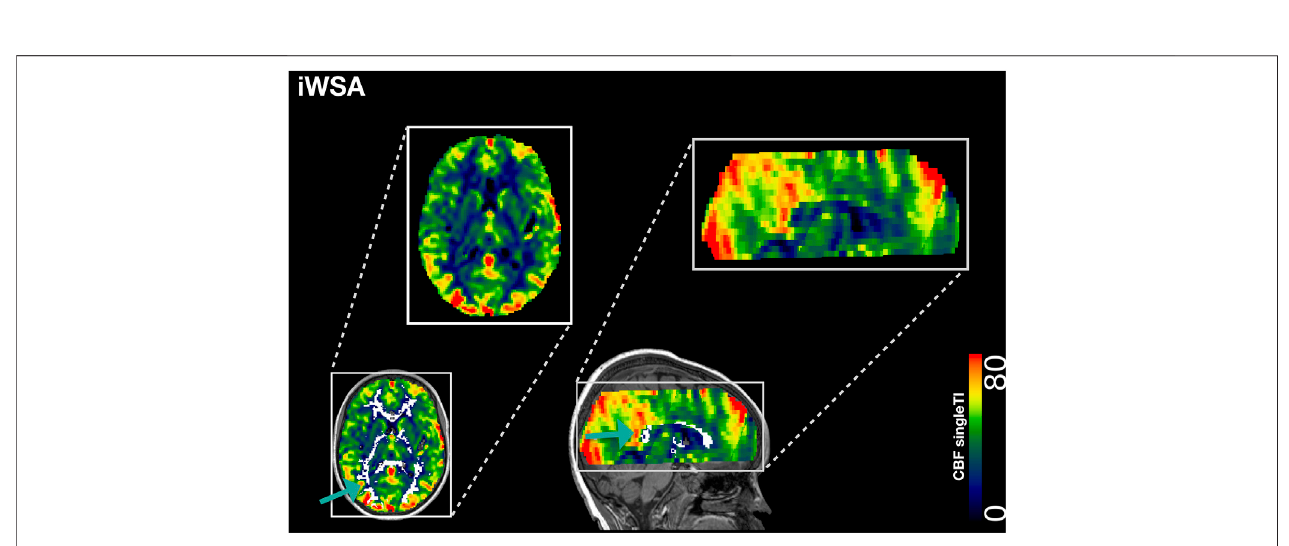
FIGURE2| IndividualWatershedArea.Showingtheindividualwatershedarea(iWSA)regionofinterest overlaidinwhiteonasinglein fl owtime cerebralbloodblow (CBF) map from a representative participant with sickle cell anemia (male, 8 years of age).